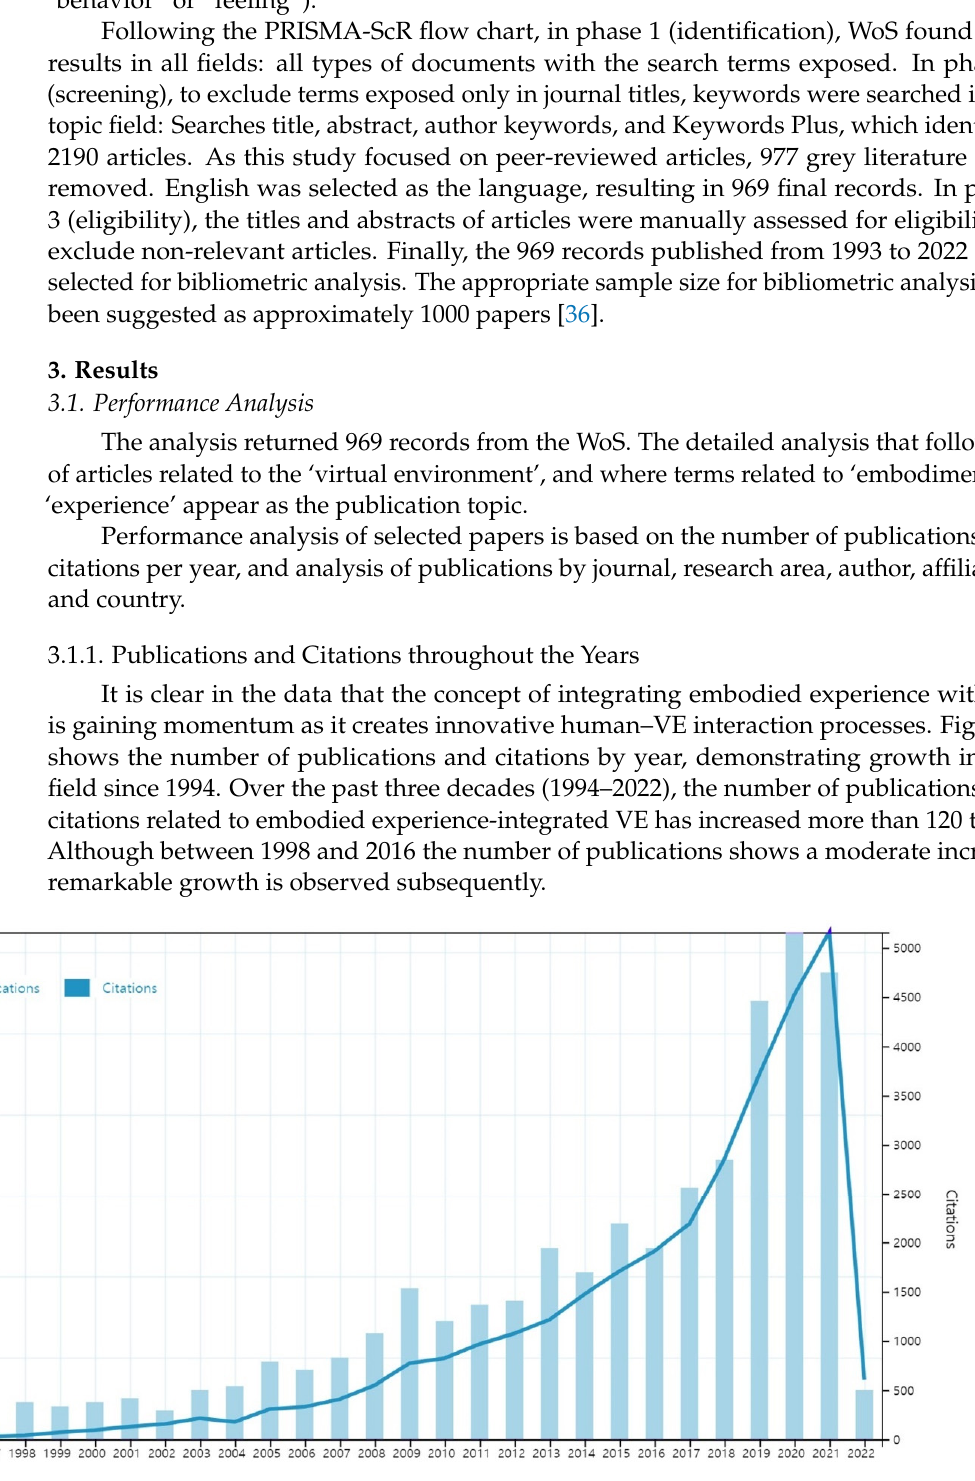
Figure 1. Number of publications and citations per year via